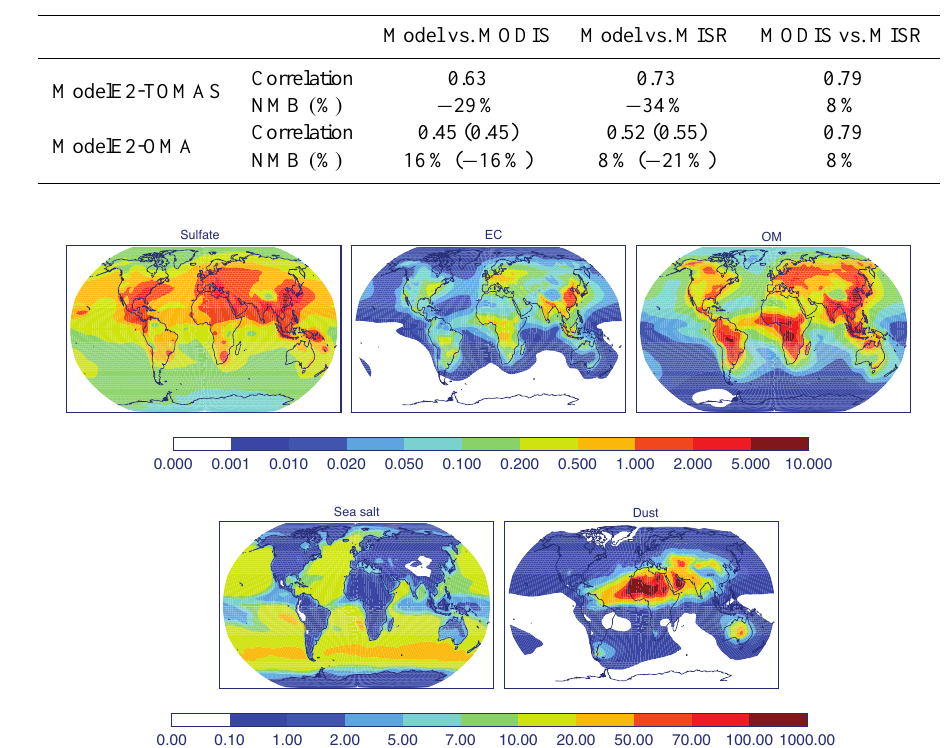
Table 6. Statistical measures of model predictions compared to satellites. For ModelE2-OMA, the model prediction without nitrate aerosols is also presented in parentheses.